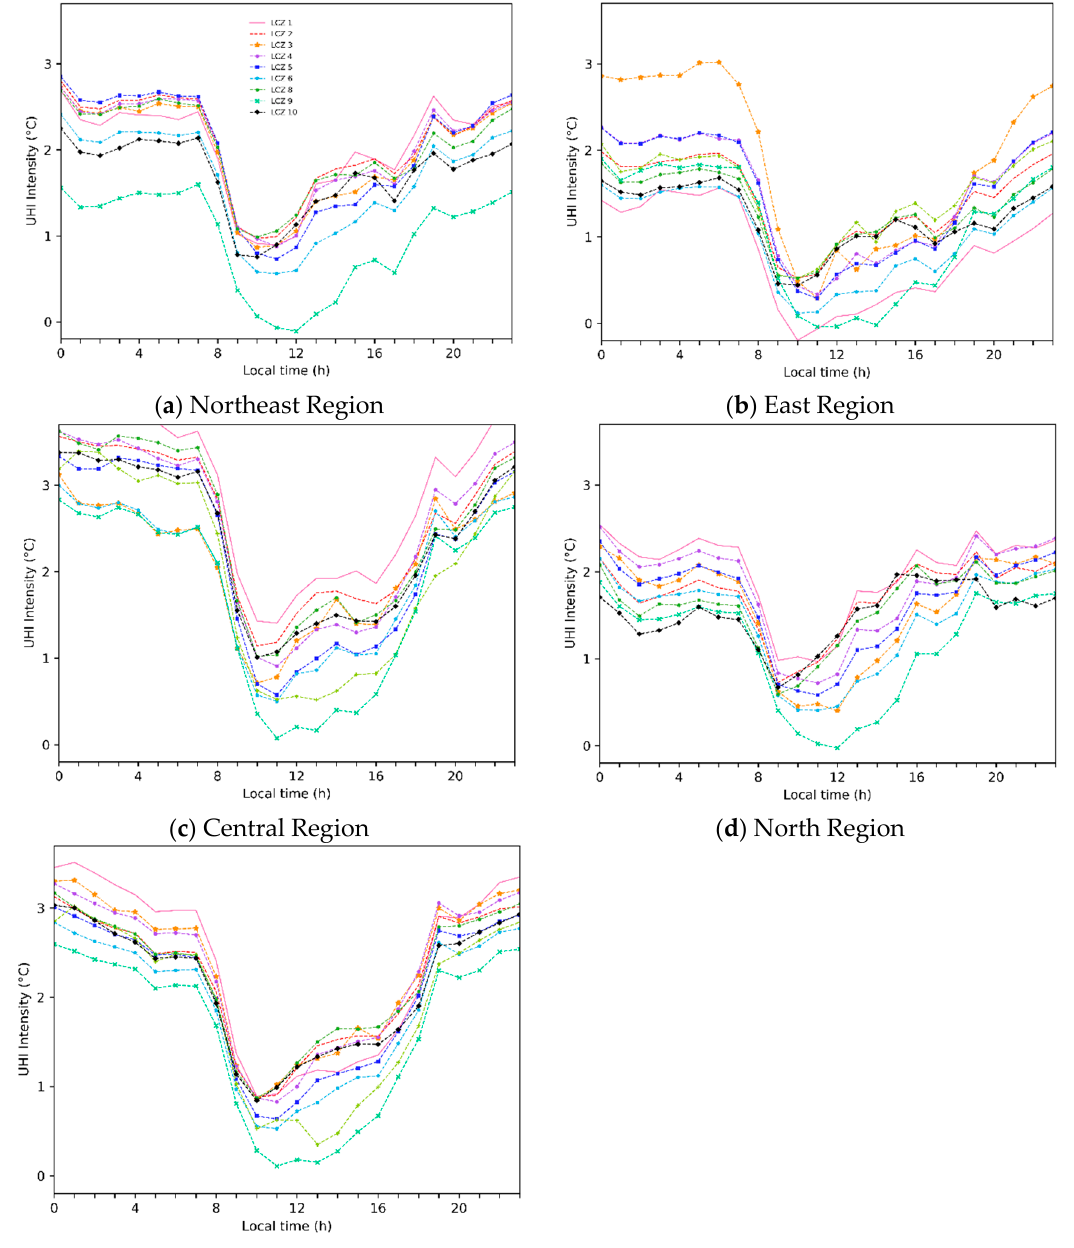
Figure 6. Diurnal variation of the UHI intensity assessment for the ( a )Northeast Region, ( b )East Region, ( c )Central Region, ( d )North Region, and ( e )West Region during April 2016.